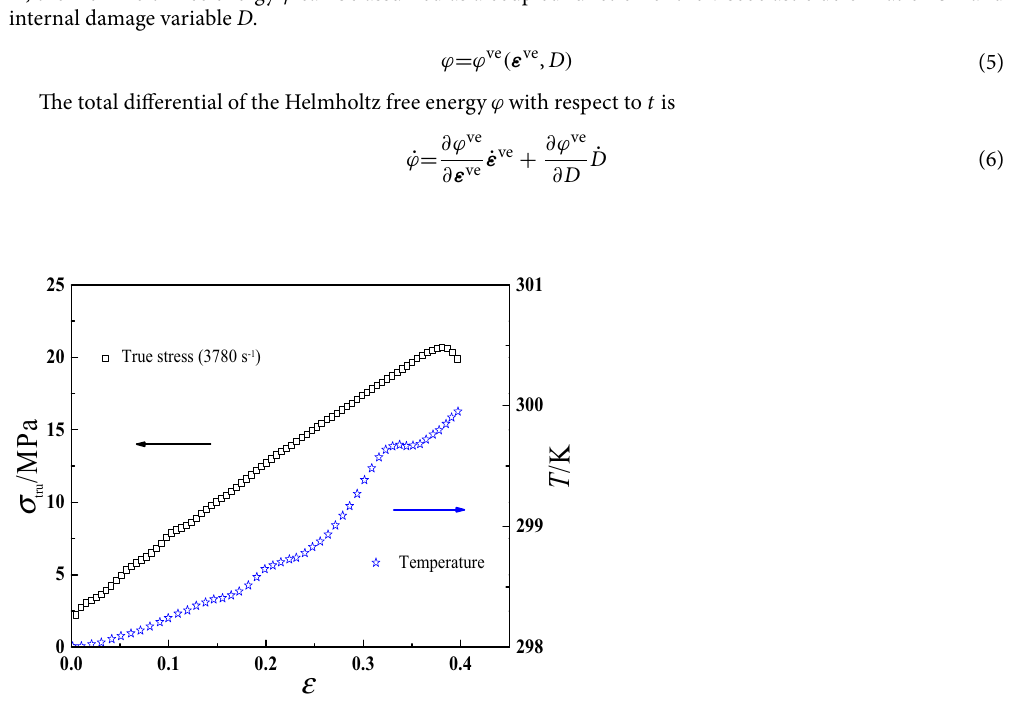
Figure 2. Stress–strain-temperature curves for HTPB propellant 26